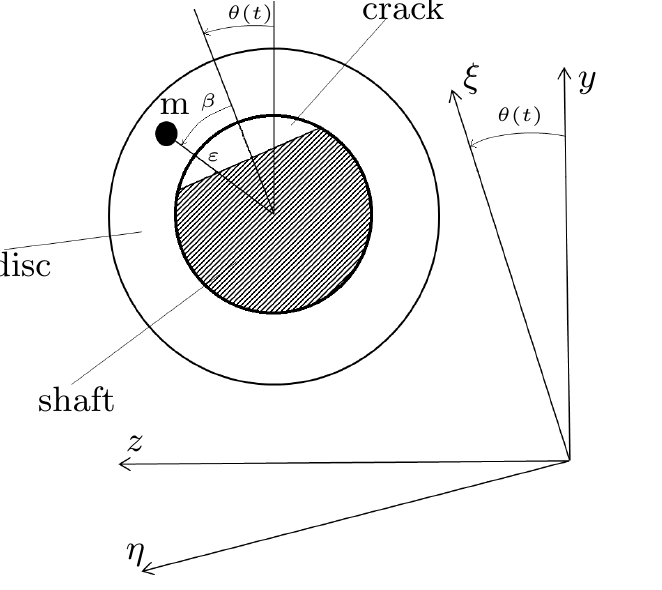
Figure 2. Stationary ( x , y , z ) and rotating ( ζ , ξ , η ) coordinate systems